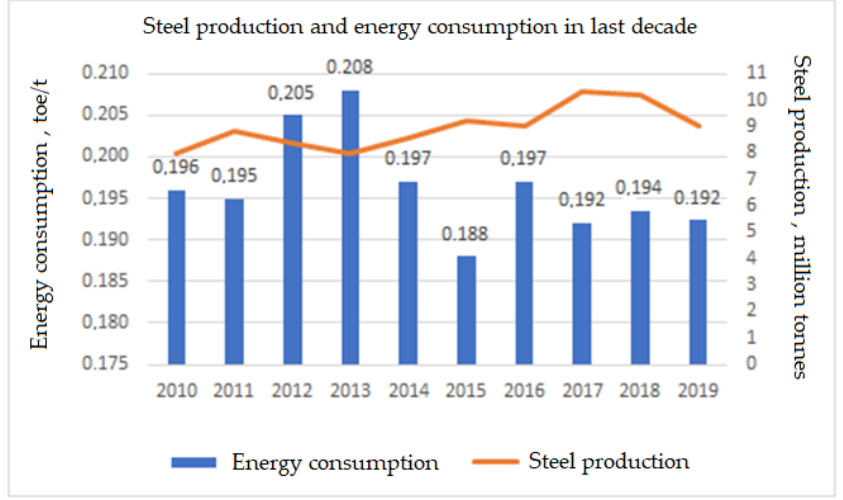
Figure 6. Energy consumption (intensity) and steel production in 2010–2019.